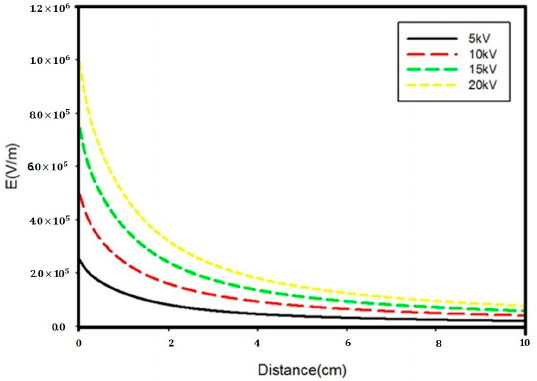
Figure 5. Variation of electric field strength as a function of distance at the applied voltages.